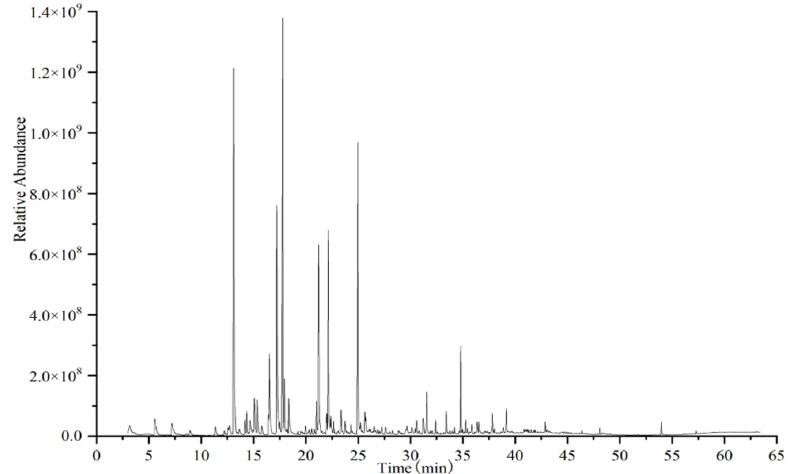
Figure 1. The representative total ion chromatography of sun-dried black tea. Table 1. Odor-active compounds detected by GC-O and GC-MS in sun-dried black tea samples (11 samples).